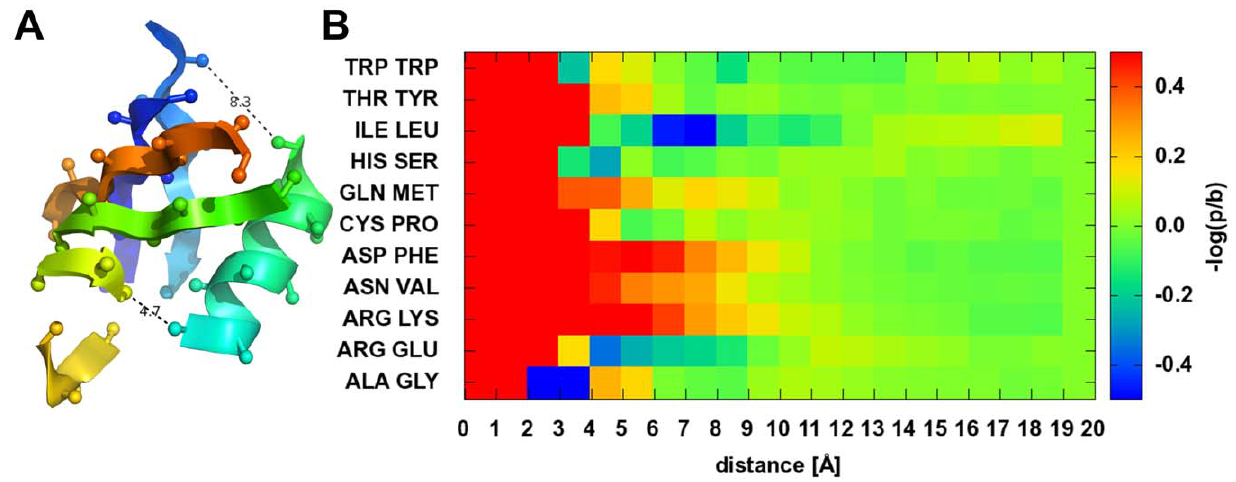
Figure 2. Amino acid pair distance potentials. In A the idealized structure of 1ubi with C b and H a 2 atoms is shown with the distances between ILE 32 and LEU 56 (4.7 A˚) and between LYS 11 and GLU 34 (8.3 A˚). B shows selected amino acid pair distance potentials for Trp-Trp as an example for p -stacking interaction, ILE-LEU as an example for vdW apolar interaction, ARG-GLU as an example for Coulomb attraction, and Arg-Lys as an example for Coulomb repulsion.